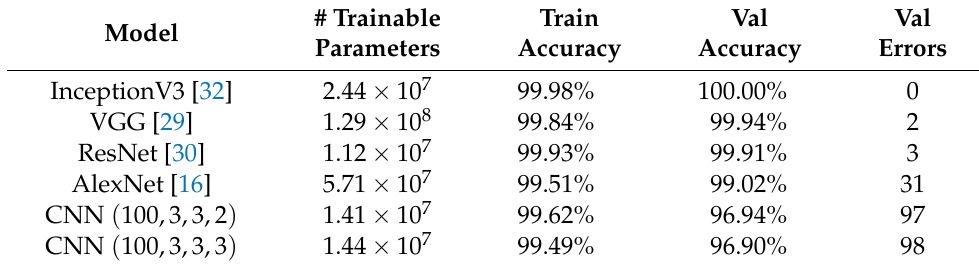
Table 2. Performance of the trained piece